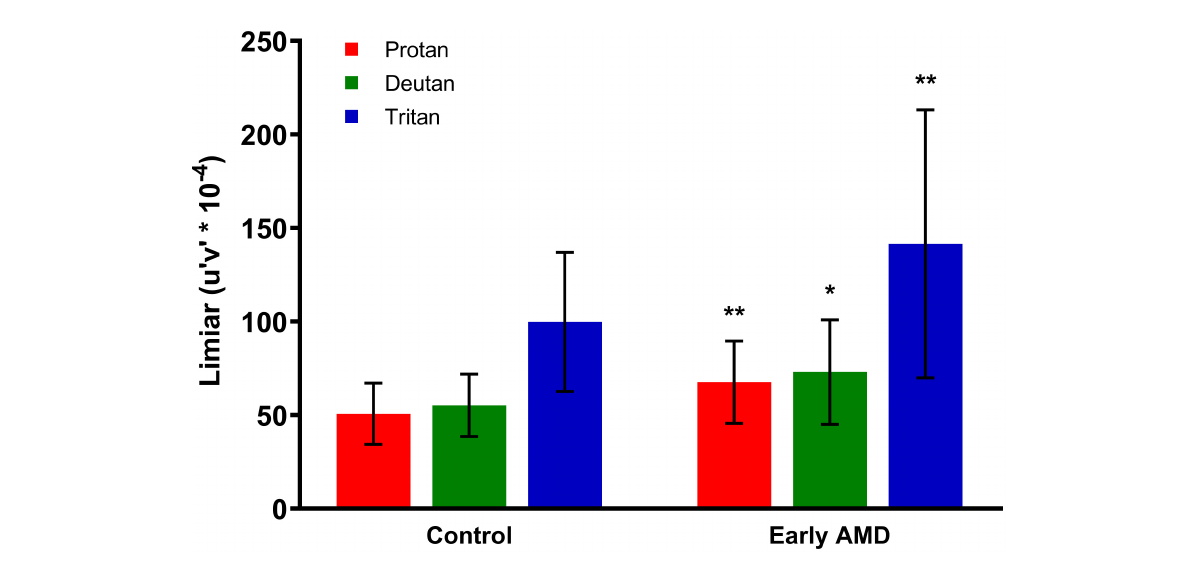
FIGURE2 Cambridge Color Test (CCT) results. The performance for color discrimination is represented by color discrimination thresholds along protan, deutan, and tritan axes for the control and early dry age-related macular degeneration (AMD) groups. Statistically significant comparisons between the respective color confusion axes in the two groups are marked with asterisks. Unpaired t -test. **Protan ( p = 0.0087), *deutan ( p = 0.0180), **tritan ( p = 0.0095). CCT, Cambridge Color